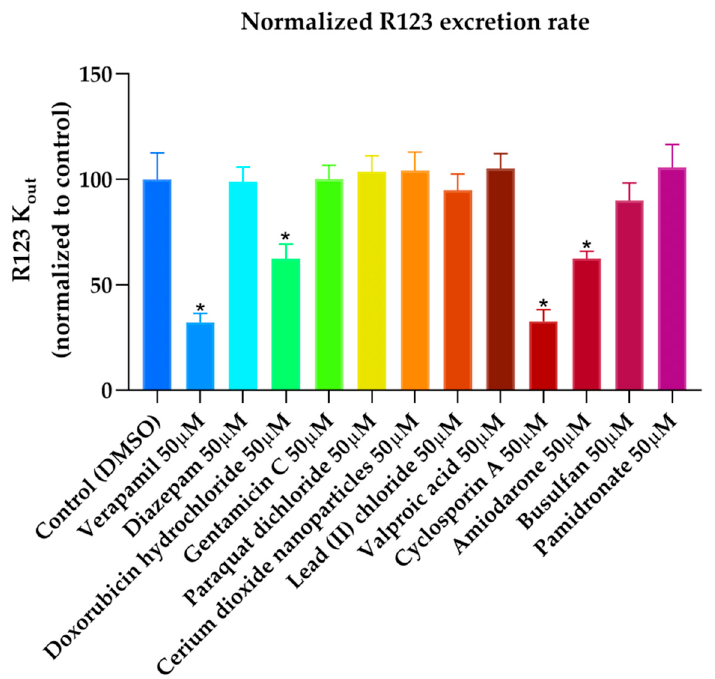
Figure 11. E ff ects of drugs on the rate of excretion of rhodamine 123 (R123) out of Caco-2